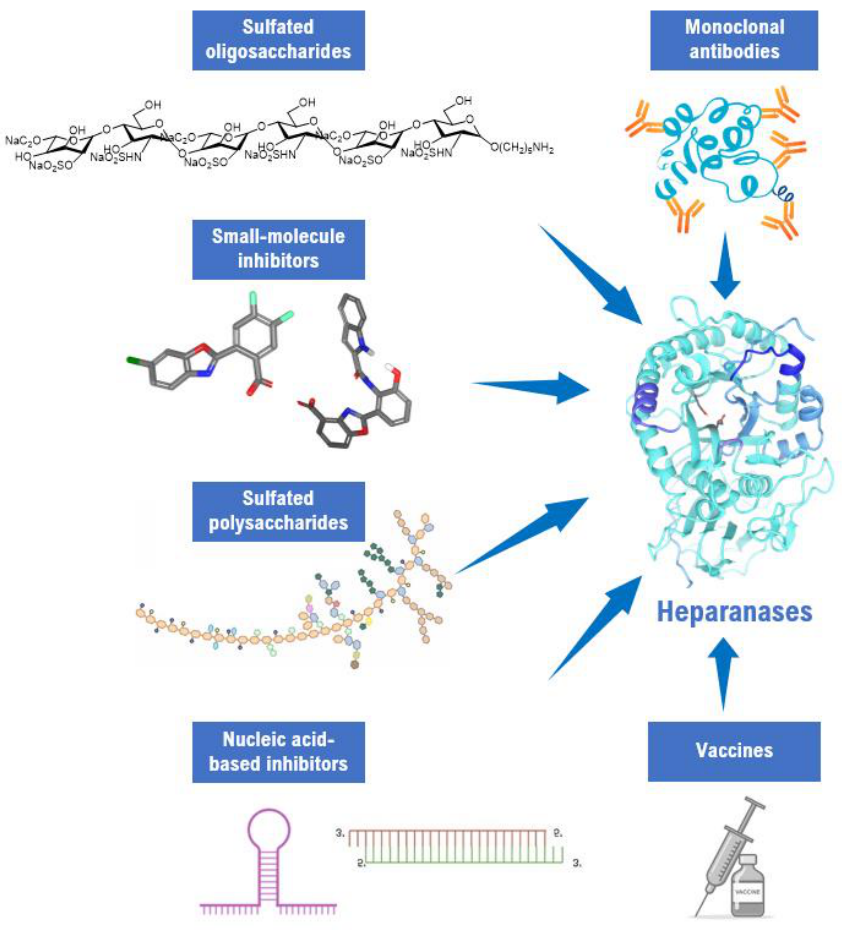
Figure 2. Approaches developed to suppress hpse gene expression and inhibit HPSE catalytic activ- ity